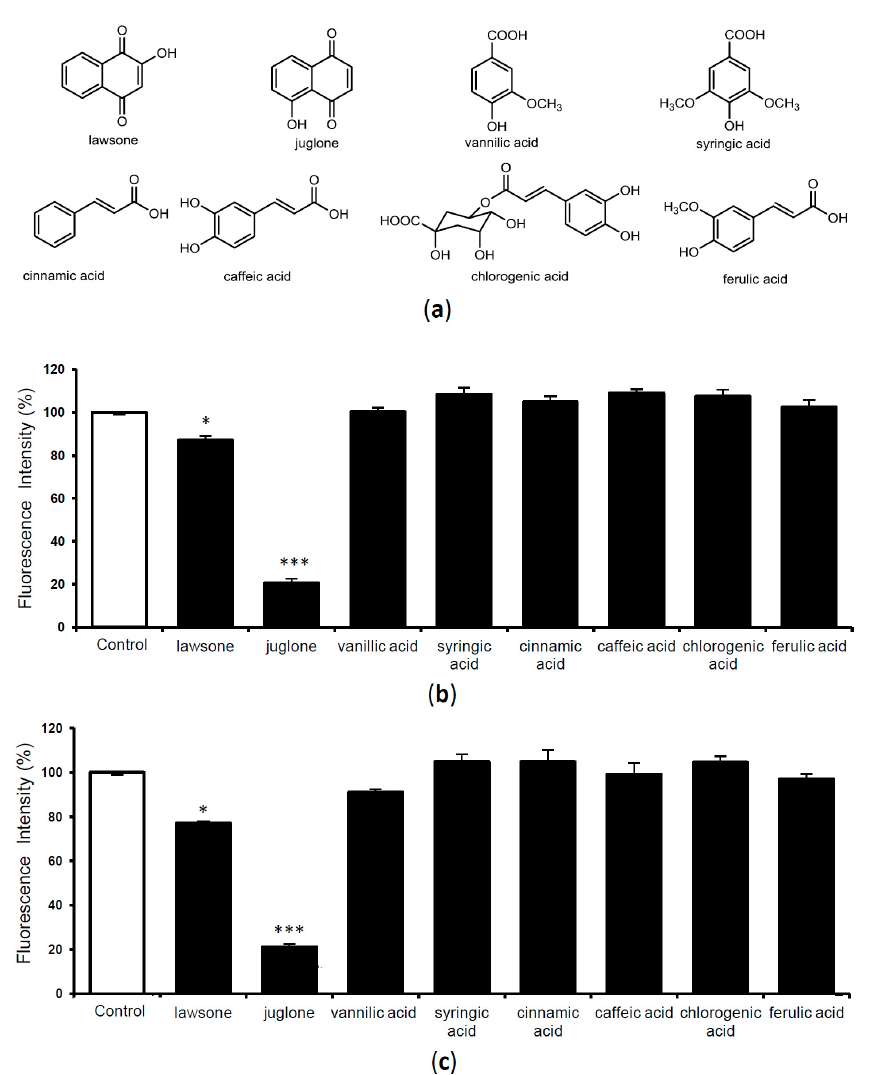
Figure 4. The chemical structures of compounds selected for activity evaluation ( a ). The amyloid fibril disrupting capacity of compounds (10 µ M) when incubated with V30M-TTR tetramer ( b ) and WT-TTR tetramer ( c ) for 24 h, then quantified with ThT assay. Data sets were analyzed by Tukey-Kramer multiple comparison test. * p < 0.05; ** p < 0.01; *** p < 0.001 as compared with control (respective TTR treated with DMSO in each experiment); All experiments were performed in triplicate (means ± SEM, n = 3).